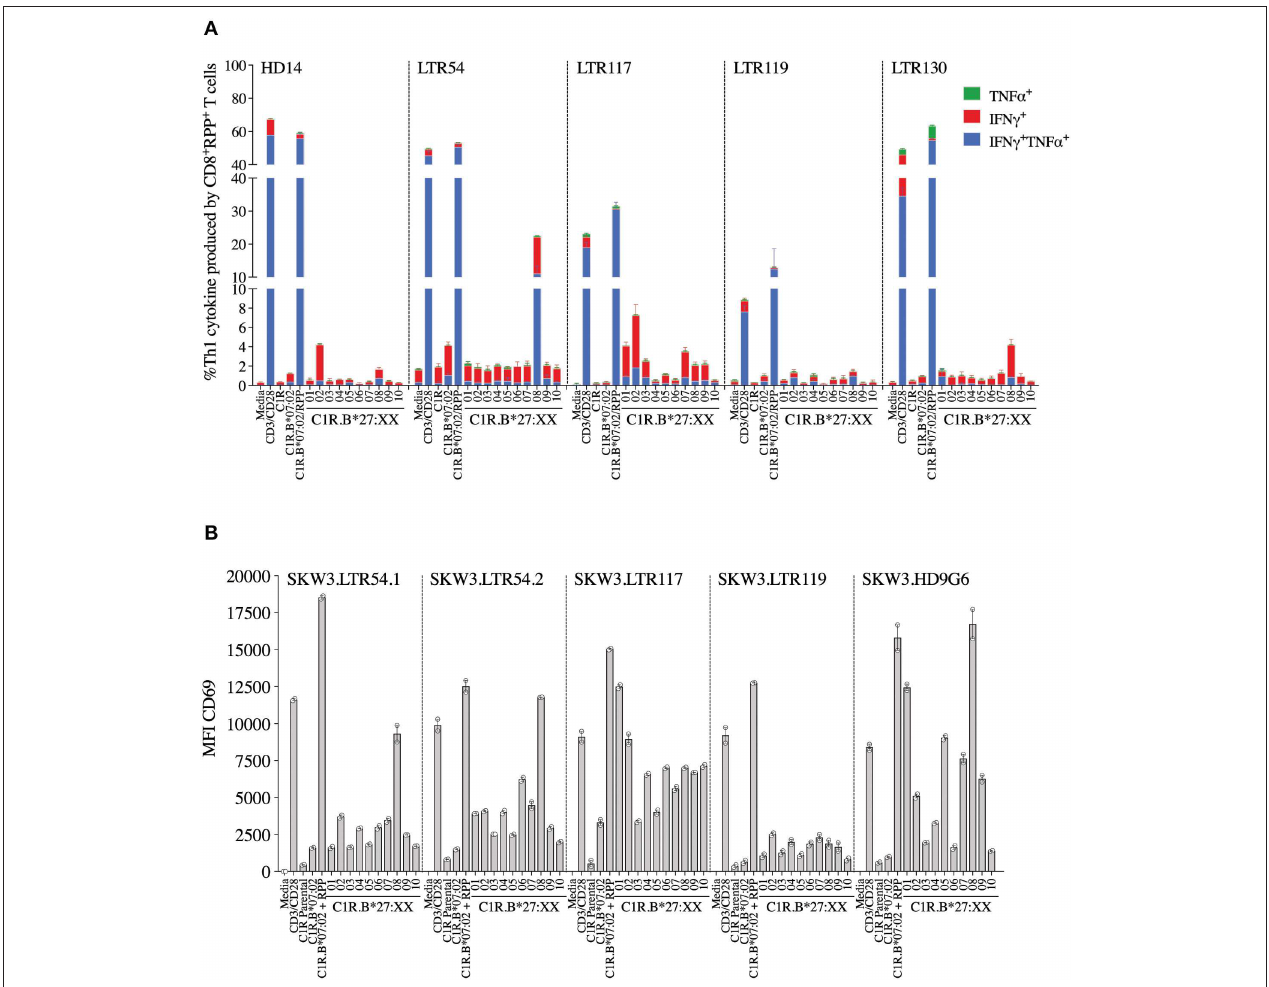
FIGURE 4 | EBV B7 RPP allorecognition of HLA-B27 molecules. (A) Day 13 in vitro expanded B7 RPP -specific CD8 + T cells were stimulated with C1R.B*07:02 ± cognate RPP peptide and a panel of C1R.B27 transfectants before performing a 6h ICS, with T cell responses measured by the production of Th1 cytokines (i.e., TNF α + or IFN γ + alone or dual TNF α + IFN γ + ) after gating on CD8 + tetramer + T cells. (B) SKW3.TCR activation was measured using cell surface CD69 upregulation after 16–20h stimulation with C1R.B*07:02 ± cognate RPP peptide and a panel of C1R.B27 transfectants. CD69 MFI values were calculated after gating on FSC vs. SSC, single cells, GFP + cells, live cells, CD3 + CD8 + cells then CD69 + cells. Mean ± SEM are shown (single experiments with duplicate data for ICS assay and CD69 assay are shown from independent biological replicates each performed at least